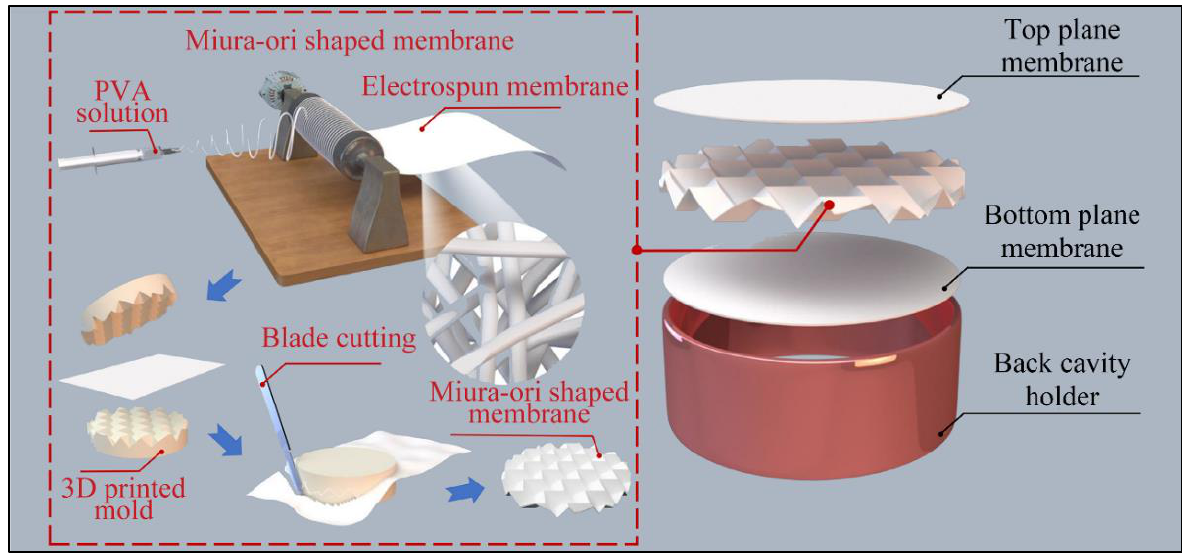
Figure 8. Fabrication of the Miura-ori sandwich structure. Reprinted with permission from ref. [39]. Copyright 2021 Wiley-VCH Verlag GmbH & Co. KGaA, Weinheim,